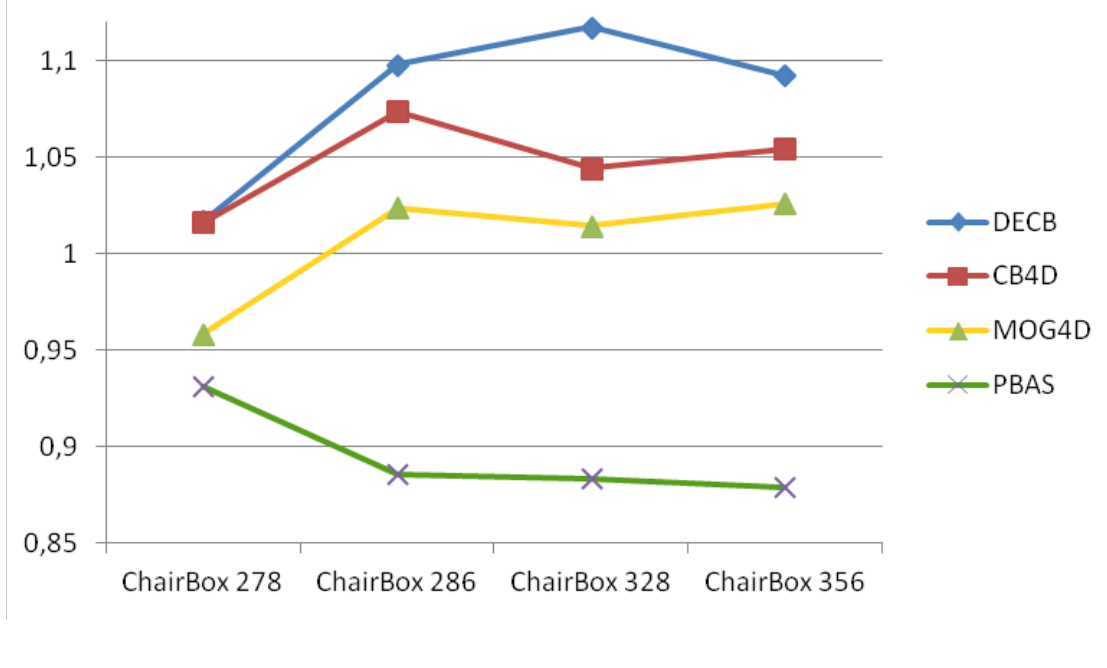
results for the 1